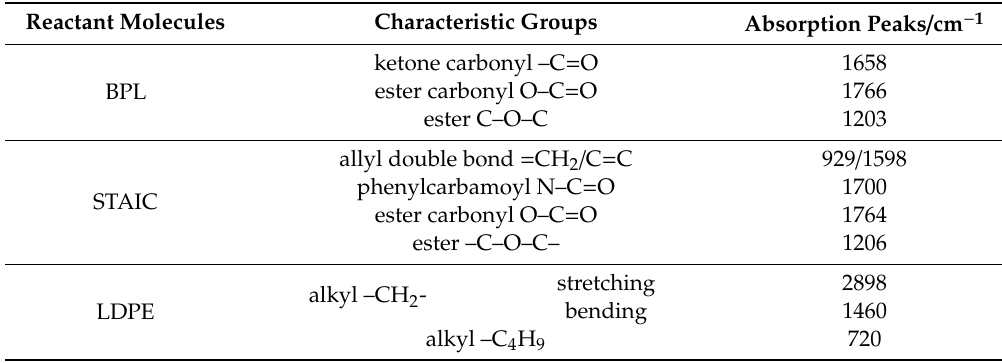
Infrared absorption peaks of characteristic groups on the reactant molecules in a photon-initiated polyethylene crosslinking reaction. BPL: 4-hydroxybenzophenone laurate, STAIC: dioleyl-2,2-,4-,4-tetraallyl isocyanurate, LDPE: low density polyethylene. Reactant Molecules Characteristic Groups Absorption Peaks / cm − 1 ketone carbonyl –C = BPL